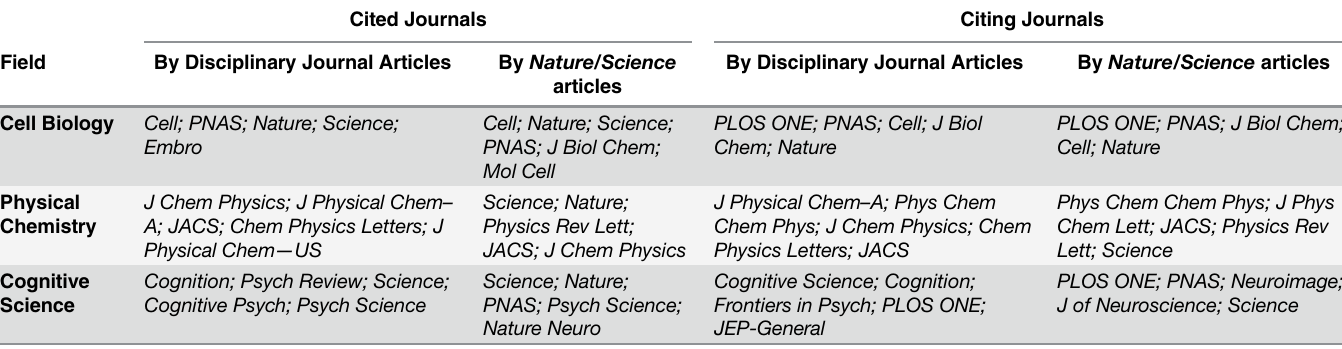
Table 1. Top Five Journals Cited by or Citing Target Articles, by Field and Journal